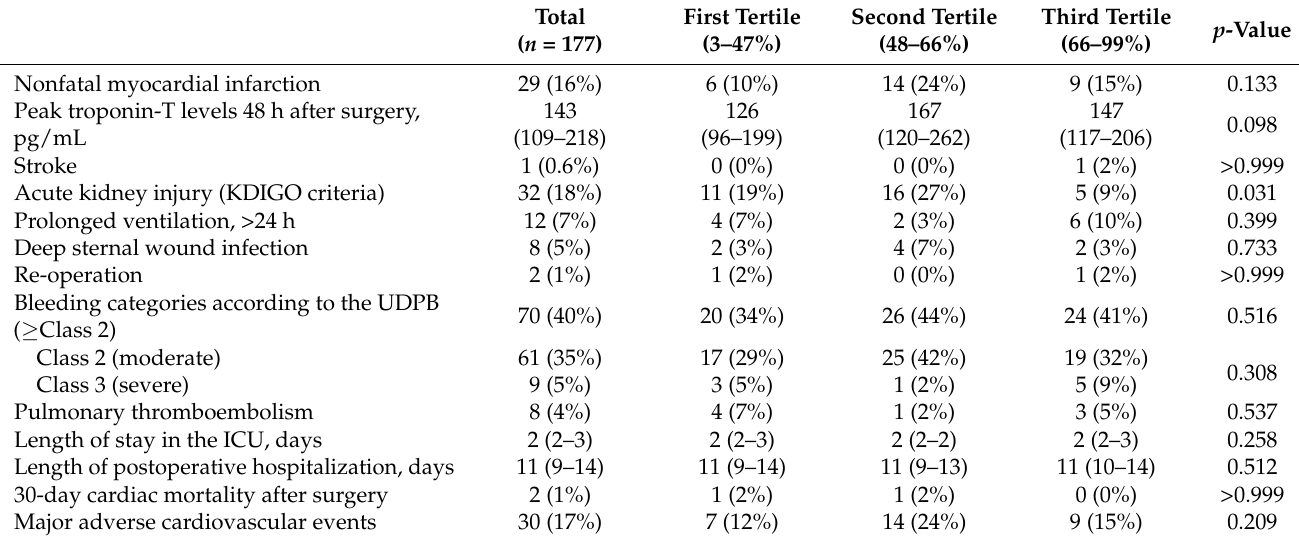
Table 2. Changes in troponin T values and postoperative outcomes.